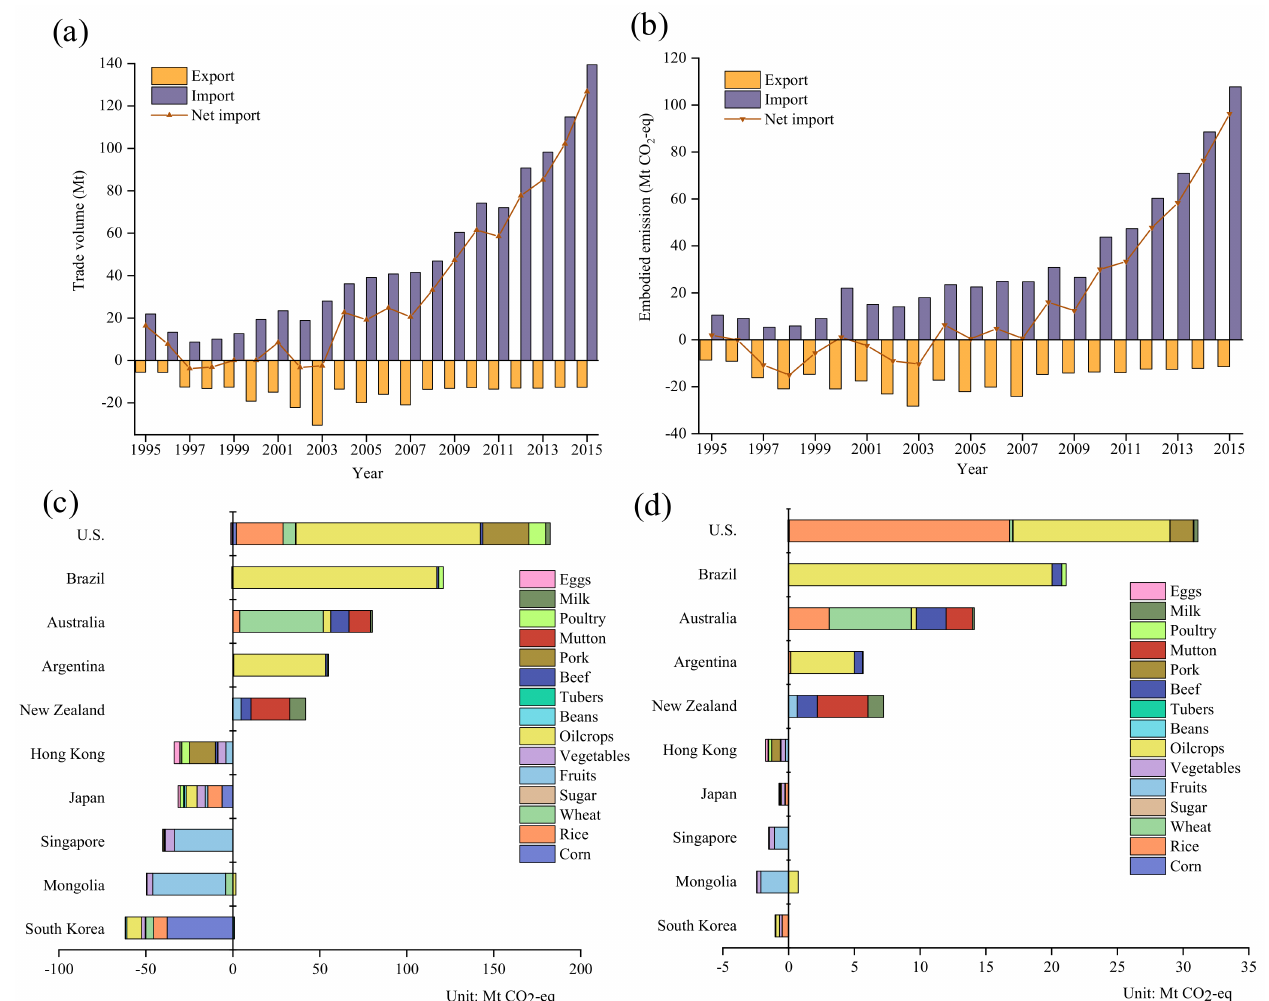
Figure 8. ( a ) China’s trade of agricultural products during 1995–2015; ( b ) GHG emissions